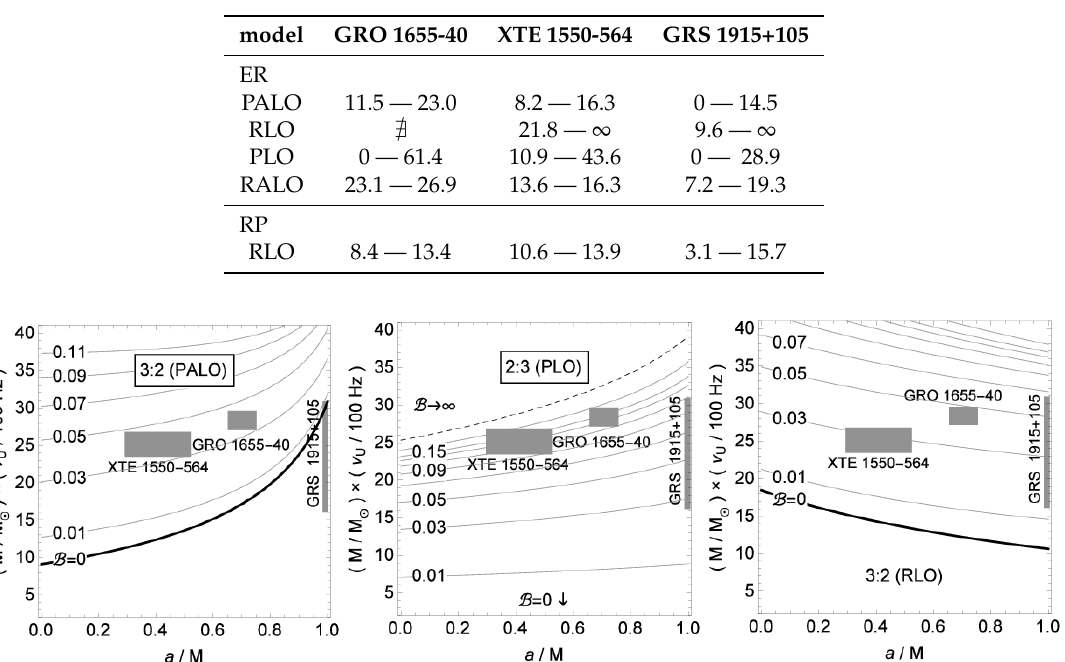
Figure 11. Fitting of three microquasar sources with HF QPOs model of charged particle oscillations with the effect of magnetic field. On the horizontal axis the black hole spin a is given, while on the vertical axis we give black hole mass M divided by observed upper HF QPOs frequency ν u . Gray boxes represent the values of black hole mass M and spin a estimated from the observations, see Table 2. Thin lines are the fitting lines given for various values of the magnetic parameter B . The non-magnetic case B = 0 is represented by thick lines. There could exist both 3:2 and 2:3 resonances and four different combinations of the magnetic field/black hole spin configurations, namely PALO, RLO, PLO and RALO, giving thus eight different cases in total, see